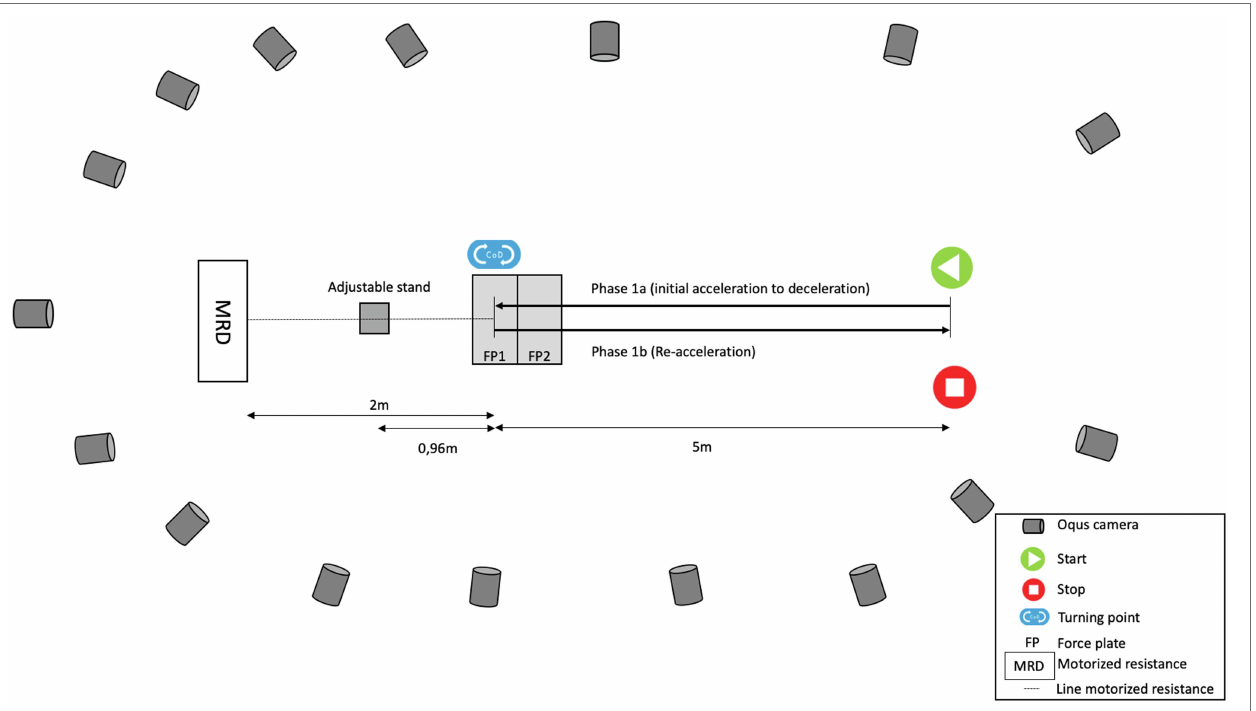
FIGURE 1 | Laboratory set up illustrating placement of Oqus cameras, motorized resistance device, force plates and start and end positions of m505